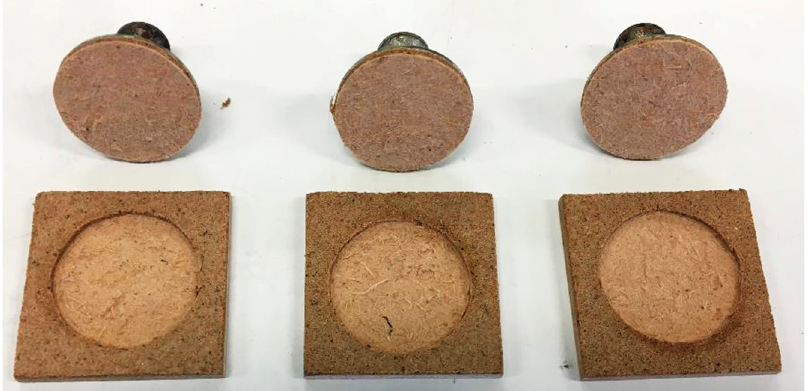
Figure 5. Photographic image of coated samples after adhesion testing, for the formulation with a 1:10 cork:resin mass ratio. The HDF substrate is visible in the circular areas where the coating was pulled off.